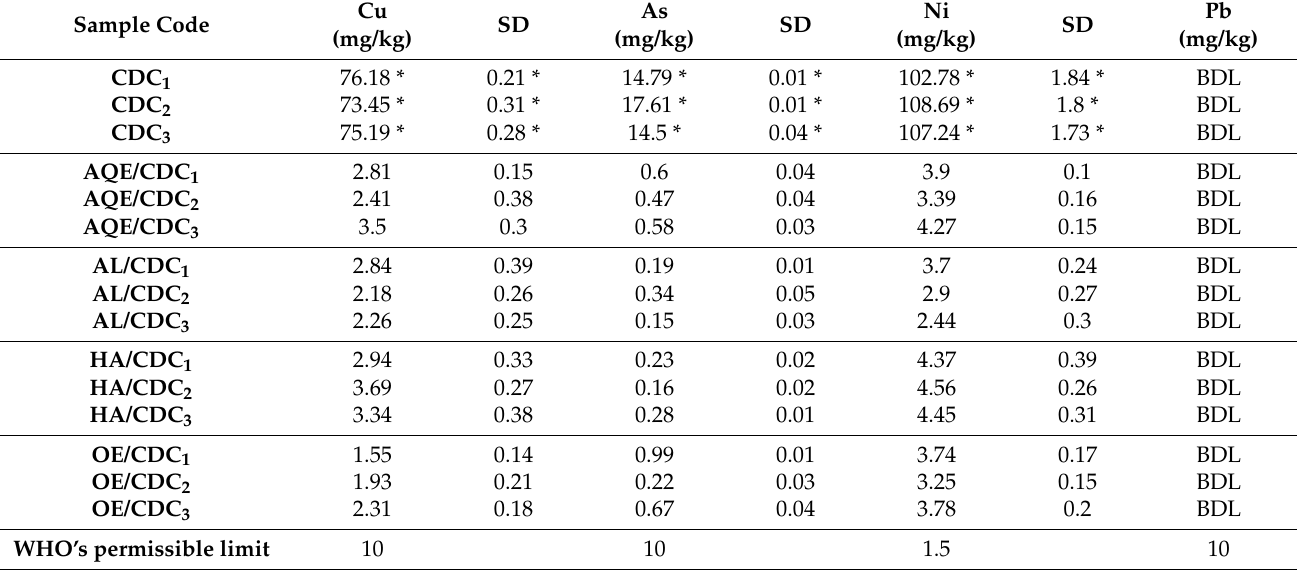
Table 6. Analyses of Croton dioicus and extracts determined by EDXRF. BDL: below detection limit. ANOVA p < 0.05 * significant difference, post hoc